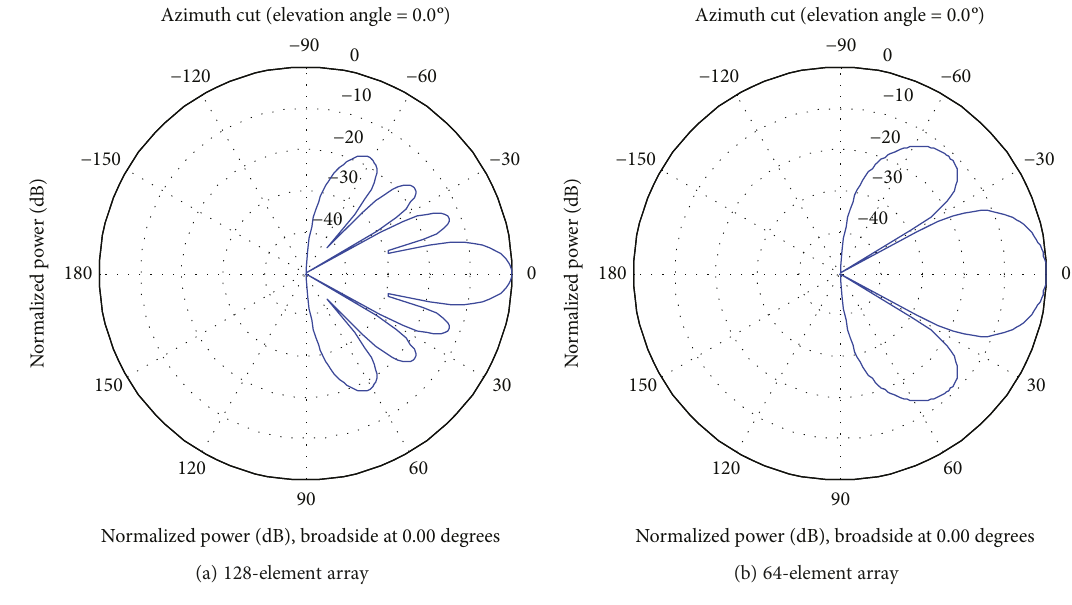
Figure 3: Radiation pattern of the antenna array with 16 subarrays in rectangular geometry.